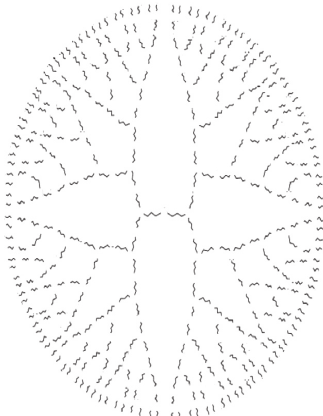
Figure 33: Propyl ether imine dendrimer (PETIM).